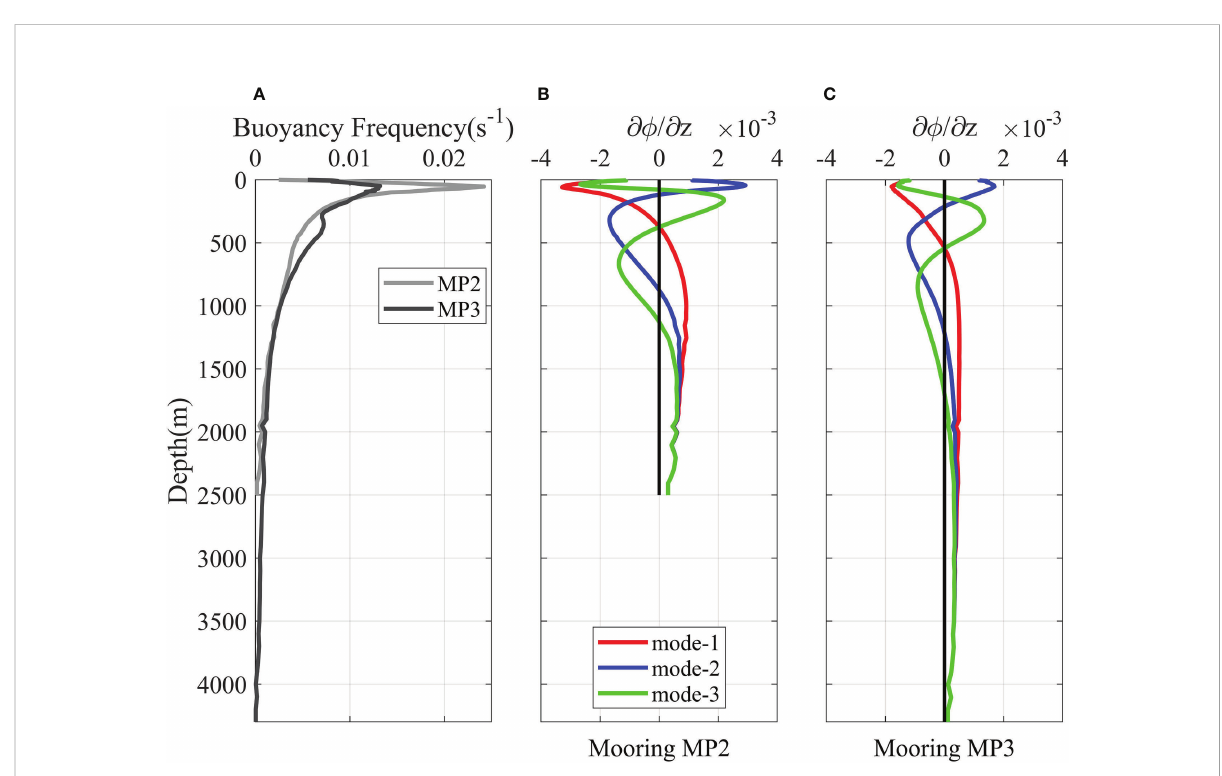
FIGURE 6 (A) Buoyancy frequency, and parts of (B, C) normal modes ∂ f m / ∂ z at the moorings MP2 and MP3.